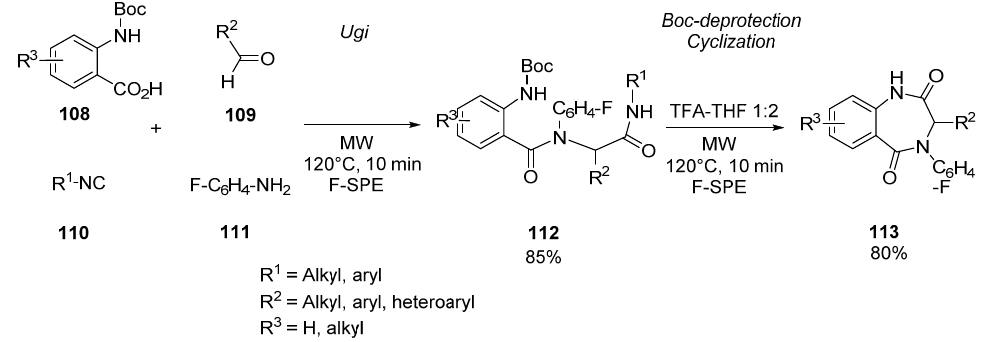
Scheme 20. Two step synthesis of benzodiazepinones via an Ugi 4-components reaction